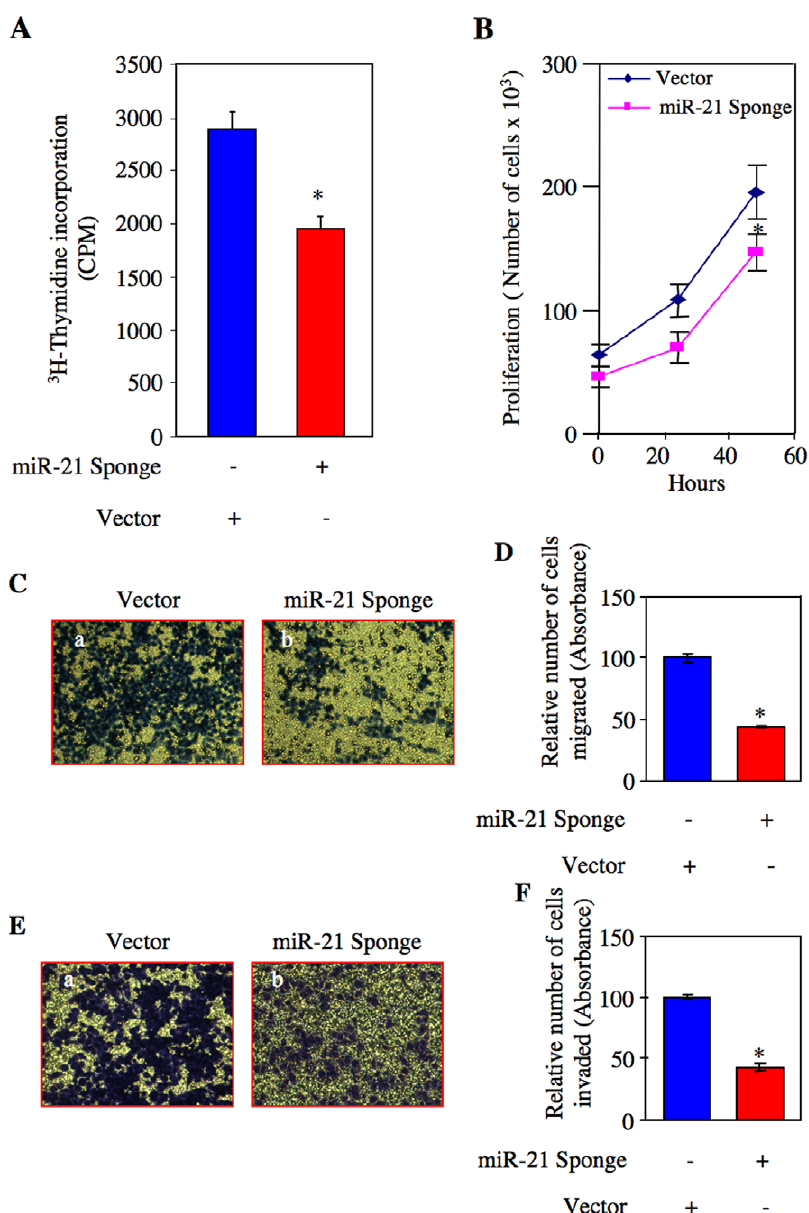
Figure 2. Effect of miR-21 Sponge on proliferation, migration and invasion of renal cancer cells. ACHN cells were transfected with miR- 21 Sponge or vector plasmids. (A) Serum-starved cells were incubated with 3 H-thymidine and its incorporation into DNA was determined as described in the Materials and Methods [115]. Mean 6 SE of 12 measurements is shown. *p =0.004 vs vector alone. (B) The cells were counted at indicated time periods as described in the Materials and Methods. Diamond and square symbols represent vector and miR-21 Sponge-transfected cells, respectively. Means 6 SE of triplicate measurements are shown. *p , 0.05 vs vector alone. (C) Serum-starved cells were seeded on to membrane in a trans-well chamber. Migration assay was performed and the migrated cells at the opposite side of the membrane were stained as described in the Materials and Methods [111]. (D) The stains in the migrated cells in panel C were eluted as described in the Materials and Methods [111]. Mean 6 SE of triplicate measurements is shown. *p , 0.0001 vs vector-transfected cells. (E) Transfected serum-starved cells were seeded on to collagen- embedded membrane in a trans-well chamber. Invasion assay was performed and the invaded cells at the opposite side of the membrane were stained as described in the Materials and Methods [111]. (F) The stains in the invaded cells in panel E were eluted as described in the Materials and Methods [111]. Mean 6 SE of triplicate measurements is shown. *p , 0.001 vs vector-transfected cells.